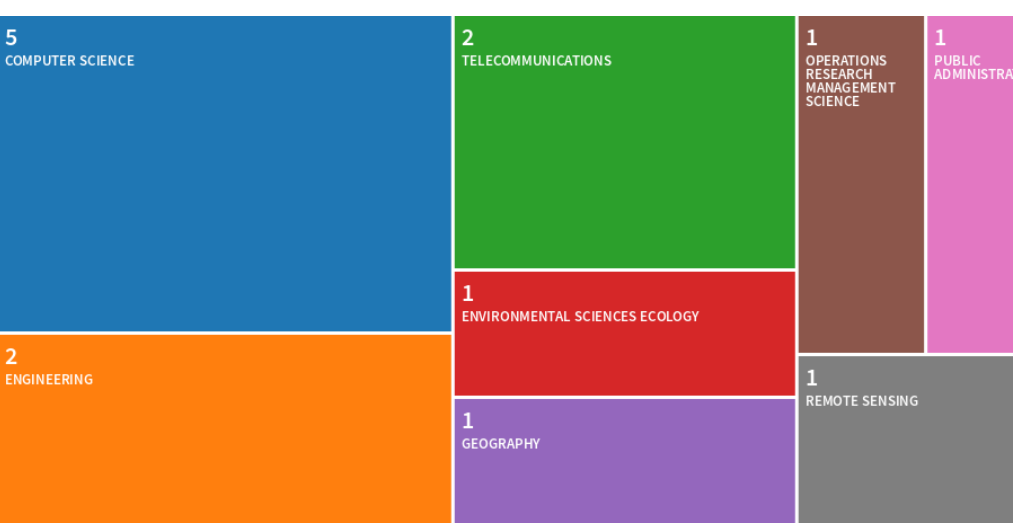
Figure 4. Number of SLR articles per year of publication.